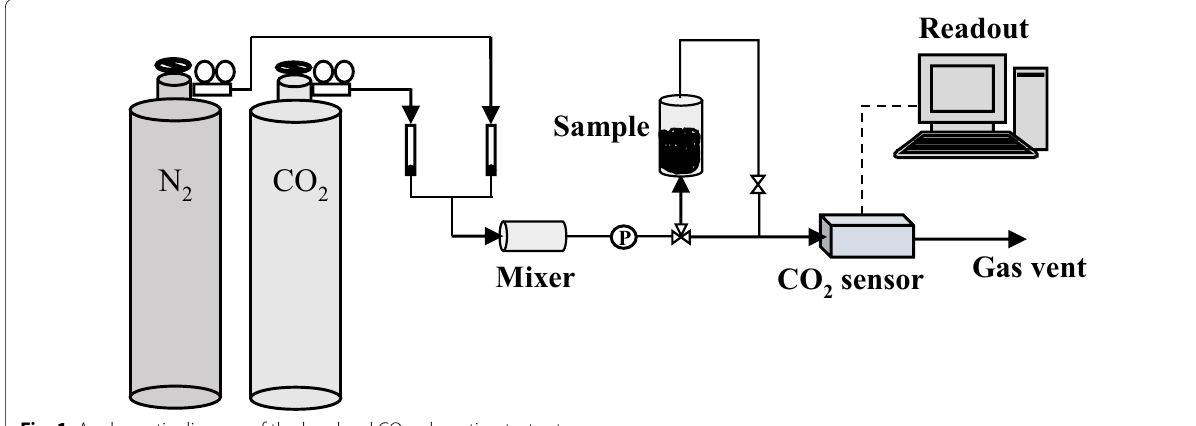
Fig. 1 A schematic diagram of the low-level CO 2 adsorption test set-up